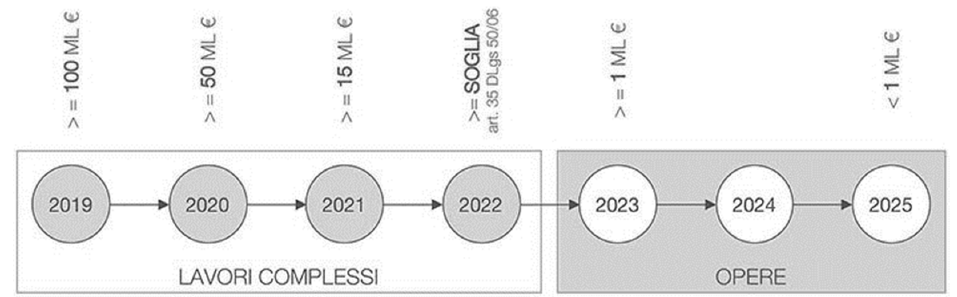
Figure 9. Economic amounts that require BIM 2019–2025.